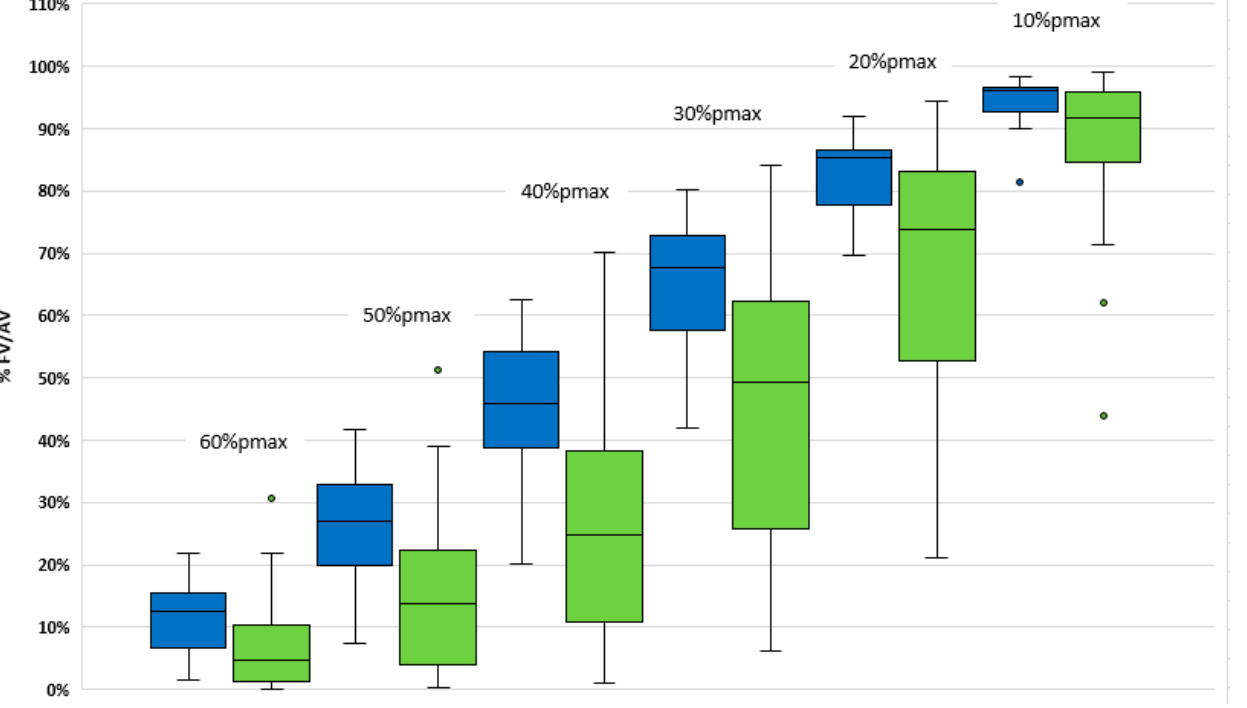
Figure 3. Functional volumes (% AV volume) using pmax threshold method in patient with normal PFT (left, blue) and with pre-existing airway disease (right, green) (FEV1/FVC < 0.7 or DLCO < 60%).